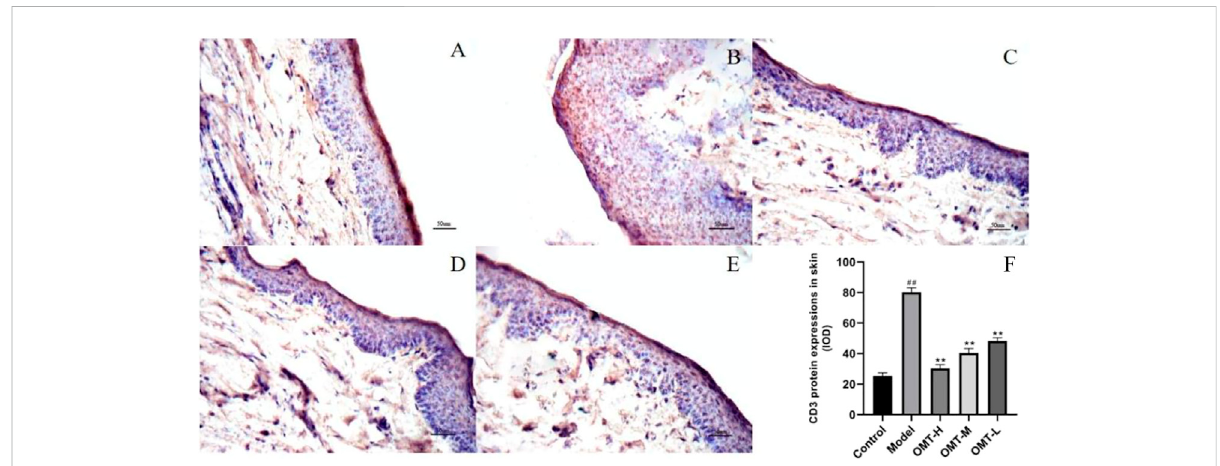
Positive expression of CD3 in skin tissue (immunohistochemical staining, × 200). (A) Normal control group; (B) Model group. (C) OMT-H group. (D) OMT-M group. (E) OMT-L group. (F) Statistical data of positive expression of CD3 in each group. ( ## , p < .01, vs. Control group; **, p < .01, vs. model group).